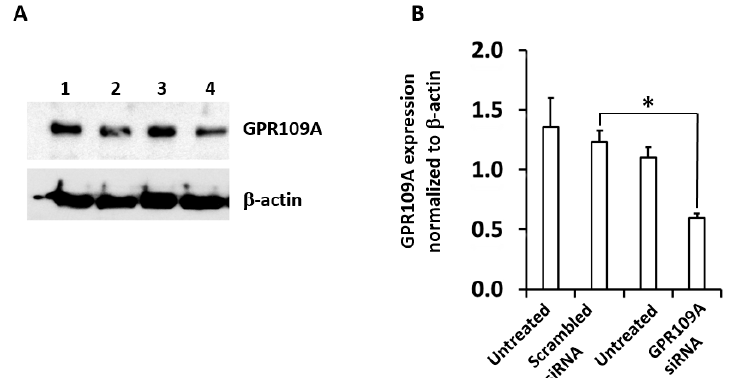
Figure 4. Knockdown of GPR109A protein expression in RAW264.7 cells after transfection with GPR109A-specific siRNA. ( A ) Western blot analysis to show the reduction in the expression of GPR109A protein (upper panel) in RAW264.7 cells, after transfection with GPR109A -specific siRNA. Untransfected cells (lanes 1 and 3), Scrambled siRNA (lane 2) and GPR109A -specific siRNA (lane 4), β -actin was used as a loading control (lower panel). ( B ) Densitometric analyses of Western blot band intensity of GRP109A protein levels were normalized to β -actin protein as an internal control. Data is presented as Mean ± SD of 3 replicates and * p <